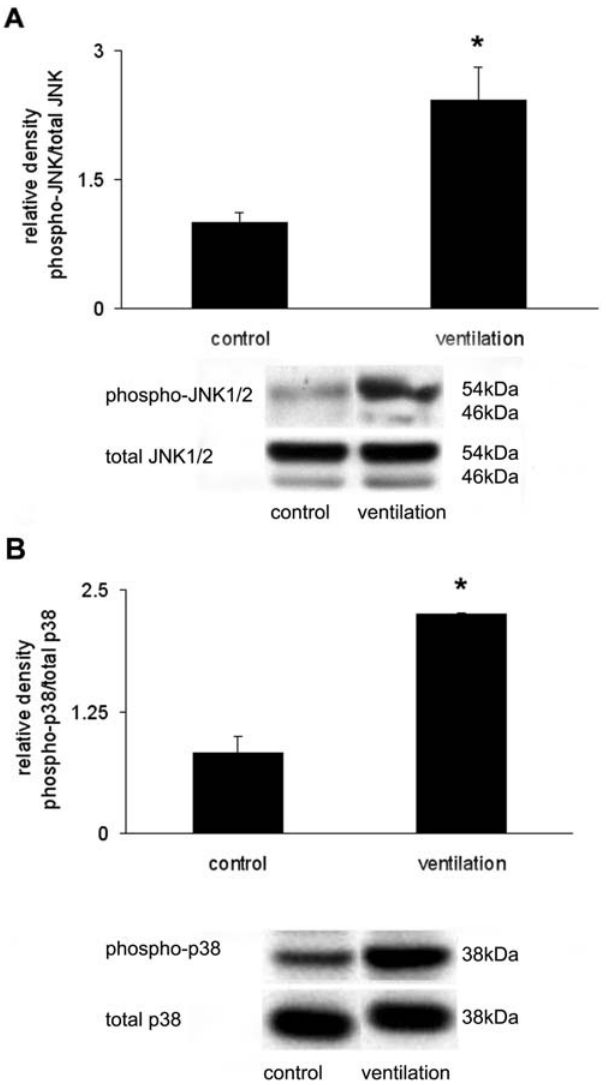
Figure 4. JNK and p38 MAPK protein activation increased following ventilation. (A) Quantified c-Jun-NH 2 -terminal kinase (JNK) activation data, expressed as phospho/dephospho (total) JNK following mechanical ventilation (20 ml/kg, 4 hours). (B) Increased p38 mitogen- activated protein kinase (p38 MAPK) activation was also detected after 4 hours ventilation and expressed as phospho/total p38. Representative blots for phosphorylated and total forms of proteins are shown. *represents significant differences between ventilation and control animals. doi:10.1371/journal.pone.0001601.g004 mice are embryonic lethal. In the absence of ventilation, no differences between the three strains were observed with respect to total cell count, protein, or TNF- a levels in the BALF. Mechanical ventilation (20 ml/kg, 4 hours) resulted in significantly higher total cell count in the BALF of wild-type mice relative to that of mkk3 2 / 2 or jnk1 2 / 2 mice (Figure 5A). TNF- a levels were signifi- cantly higher in wild-type animals than in mkk3 2 / 2 and jnk1 2 / 2 mice (Figure 5B). TNF a analysis was performed after 2 hours ventilation due to the early and transient nature of this response. When neutrophil influx was quantified following ventilation (10 ml/kg, 8 hours), we found that both mkk3 2 / 2 and jnk1 2 / 2 mice exhibited reduced leukocyte infiltration when compared to